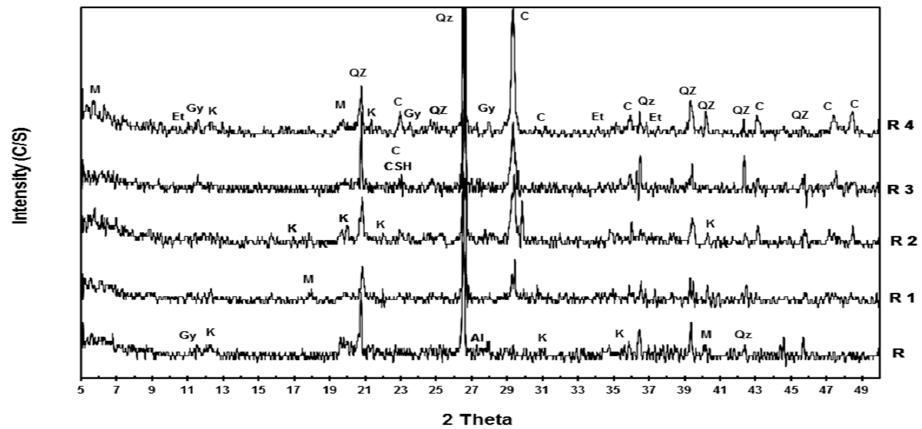
Figure 4. XRD patterns of the specimens of different mixes that had been cured for two weeks (M: (M: Montmorillonite, Et: Ettringite, Gy: Gypsum, K: Kaolinite, Qz: Quartz, C: Calcite, CSH: Calcium silicate hydrate, Al: